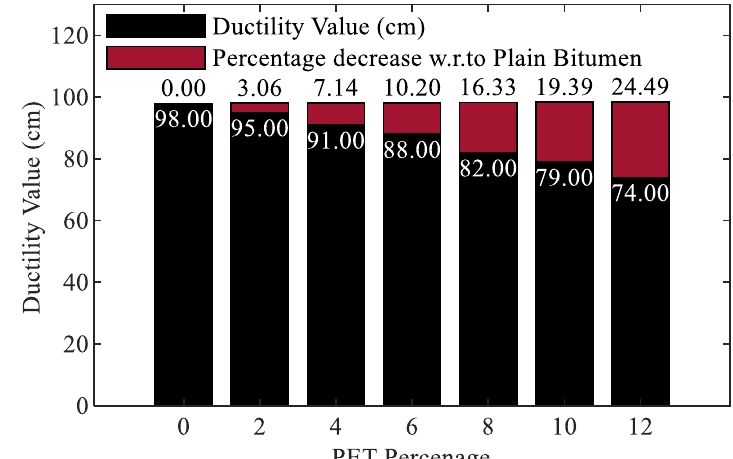
Fig. 15 Variation of ductility value with PET content